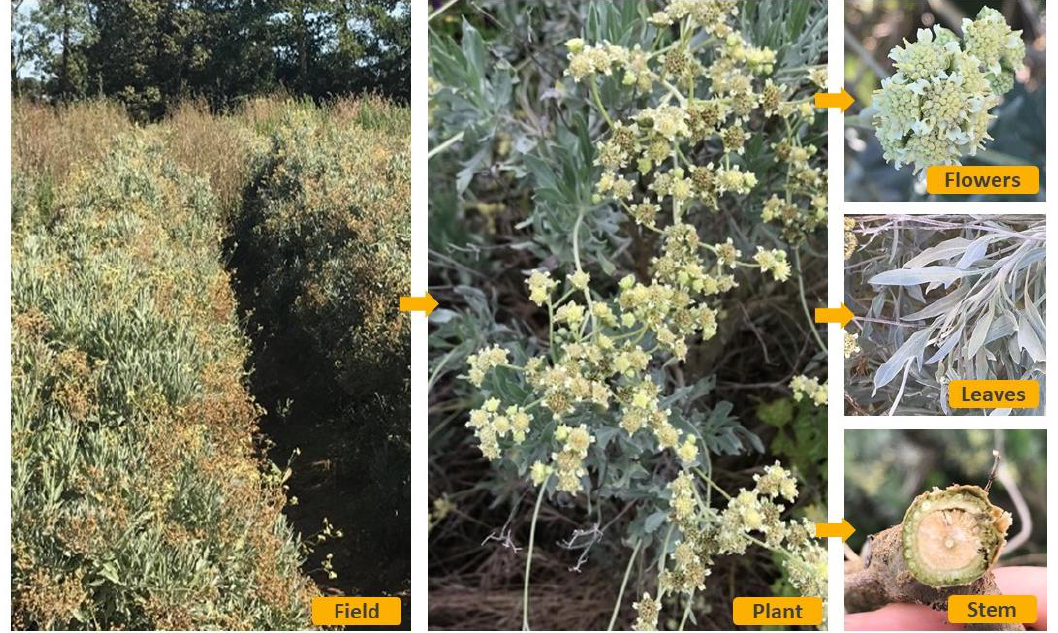
Figure 3. Field and various parts of guayule in Lansargues, south of France 2020.